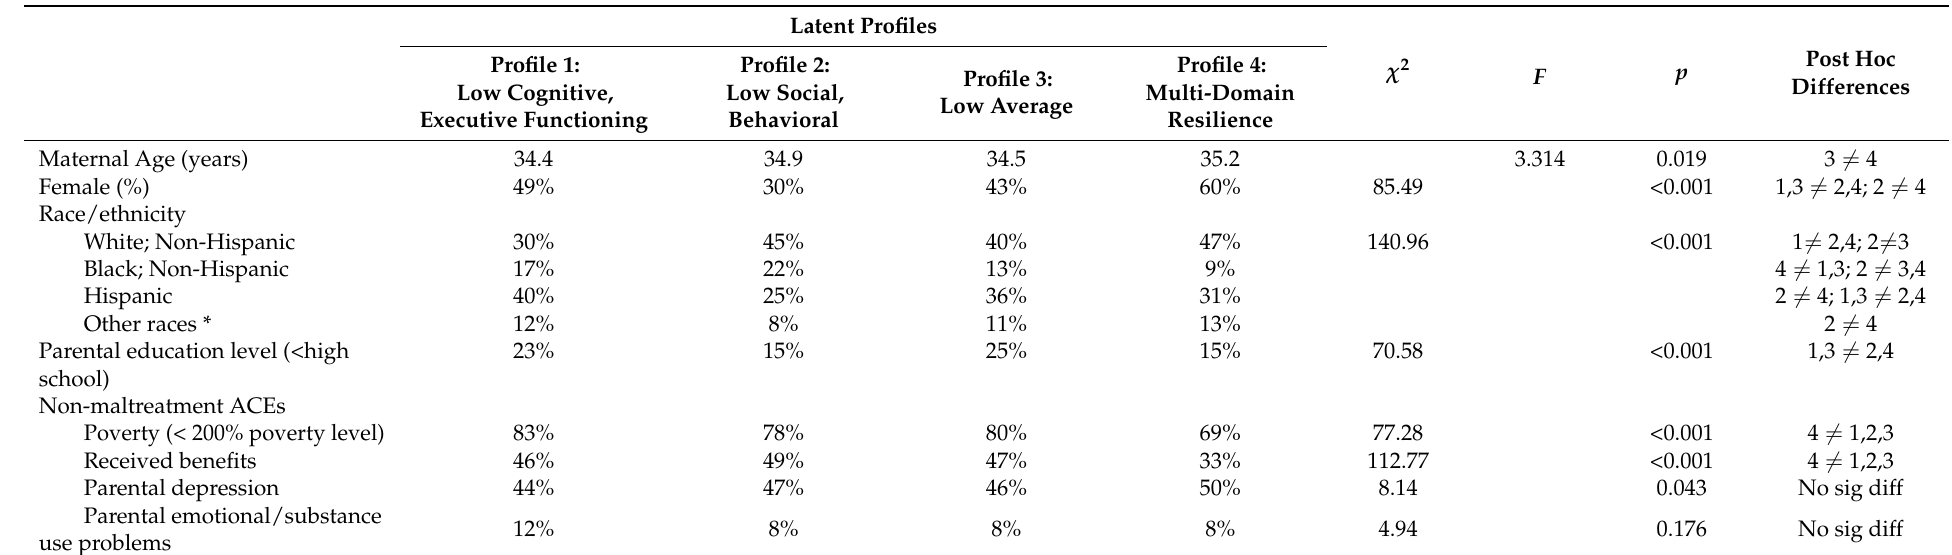
Table 3. Demographics and Non-maltreatment ACEs across Resilience Profiles ( n =